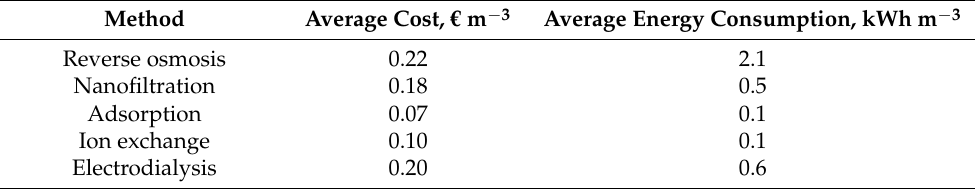
Table 8. Estimated costs of selected methods for wastewater